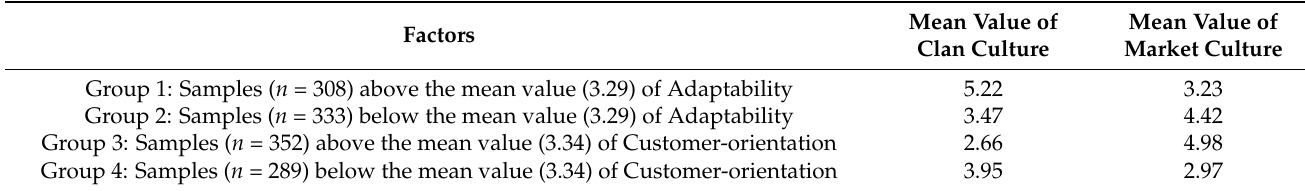
Table 6. Descriptive Statistics for Final Sample.